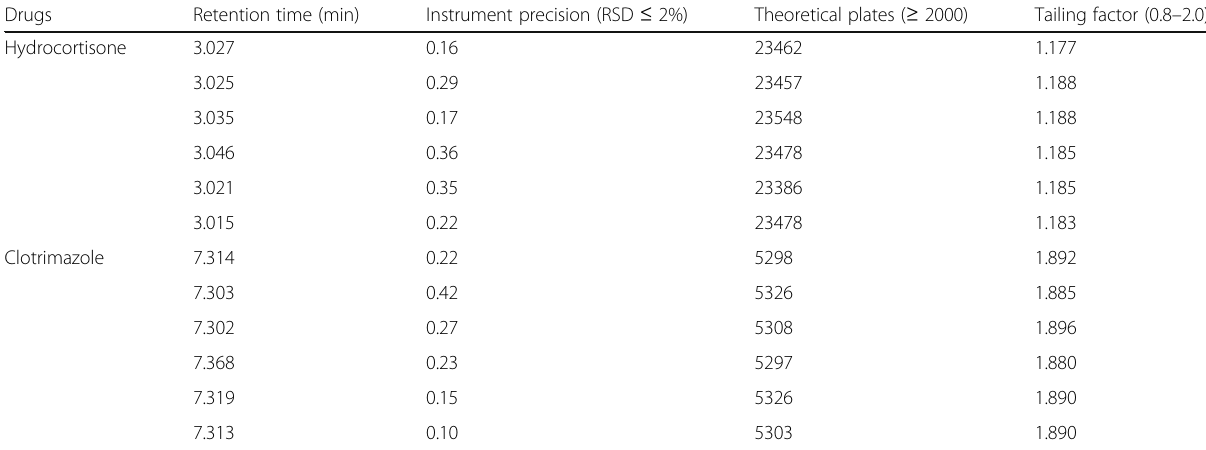
Table 1 Parameters of system suitability for hydrocortisone and clotrimazole Drugs